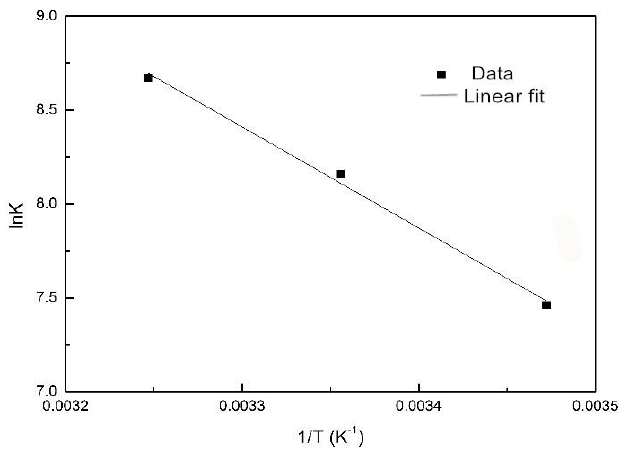
Figure 3. The relationship of lnK and 1 / T during adsorption of phosphorus.